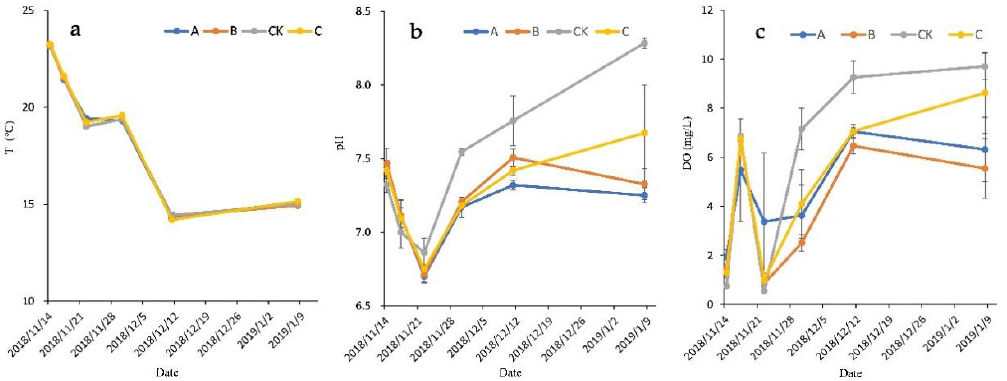
Figure 1. Variation in ( a ) T, ( b ) pH, and ( c ) DO of wastewater in groups: (A) V. natans + L. adscendens + M. vaginalis + S. chinensis ; (B) V. natans + I. aquatica + A. calamus + T. orientalis ; (C) V. natans + L. adscendens + S. juncoides + T. orientalis ; (CK) control (no plants) (the same applies in the following figures).